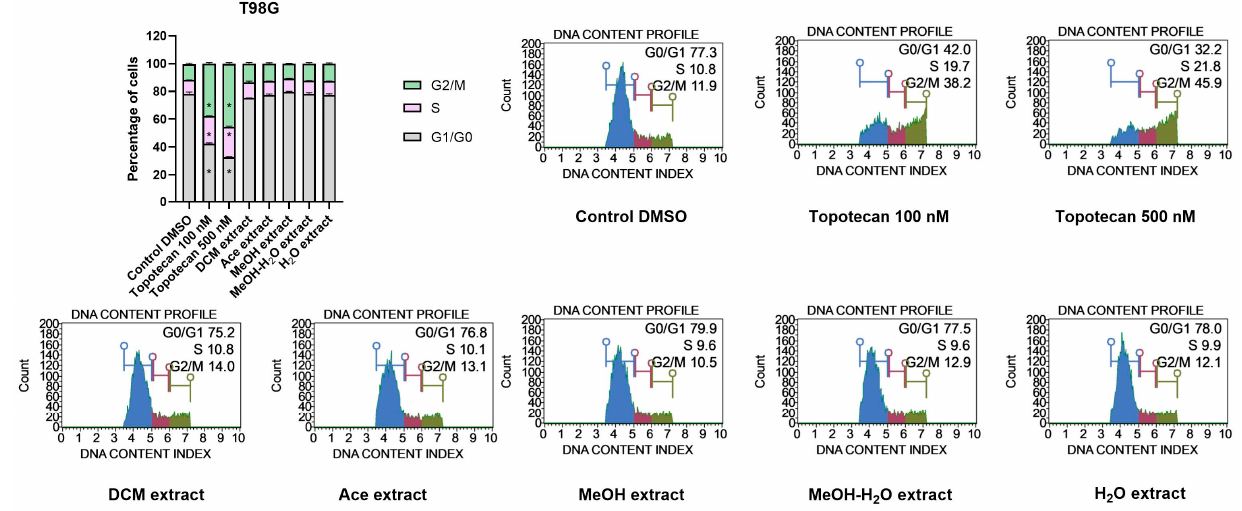
Figure 9. Cell cycle analysis of T98G cells using the Muse™ Cell Cycle Kit after 48 h of treatment. The percentage of cells in G0/G1, S, and G2/M phases of the cell cycle are presented in the bar chart. The values are shown as the mean ± SEM calculated from two independent experiments. (*) indicates statistically significant differences from the control group for a particular phase, p < 0.05. Representative histograms of the controls (DMSO—negative control, topotecan—positive control) and analysed P. glauca extracts are also presented.